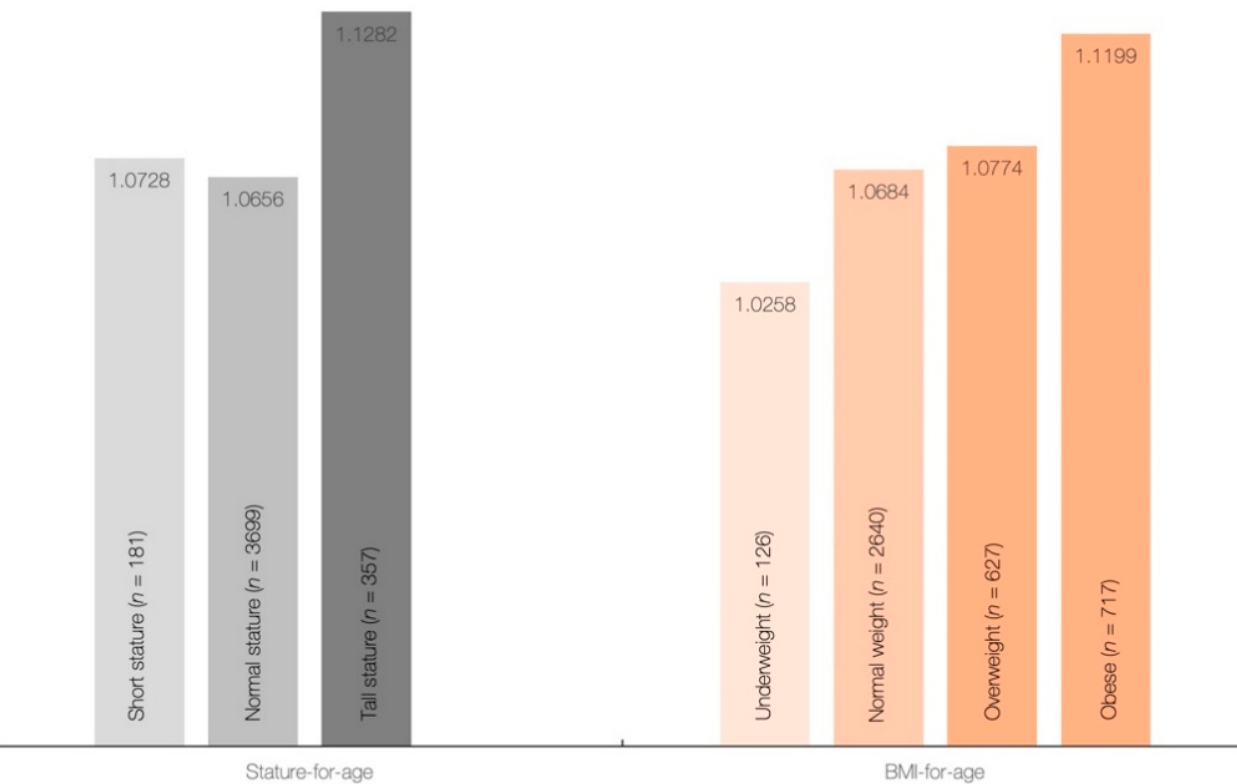
Figure 1. Dietary intake of creatine (g/day) across stature-for-age and BMI-for-age categories. Table 2. Body measures across creatine quartiles.